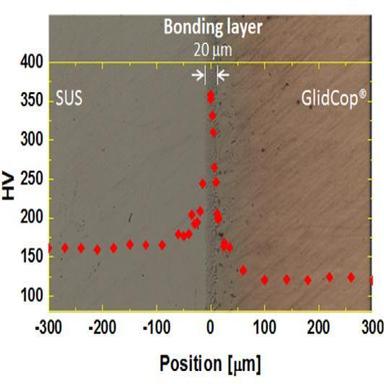
Vickers hardness (HV) distribution in the vicinity of the SUS/GlidCop® bonding interface. The 0 mm position corresponds to the bonding interface. The optical microscope image from was superimposed in the HV distribution on the same scale.